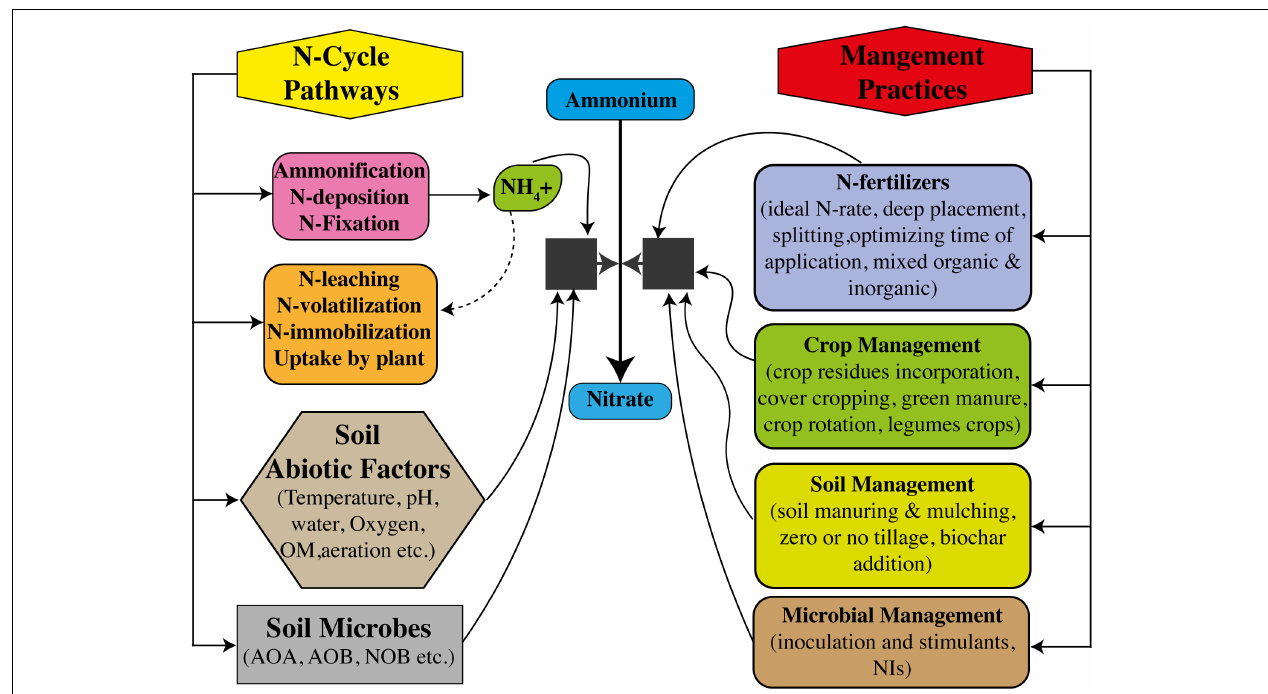
FIGURE 4 | Interactive control of nitrification to increase nitrogen use efficiency (NUE) through soil microbes and management measures of soil, crop, and N